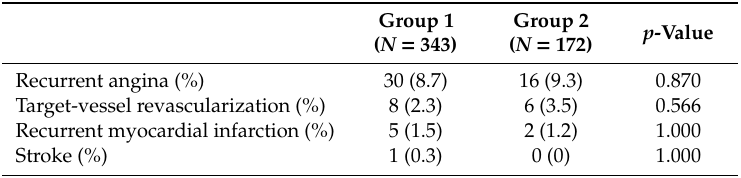
Table 3. One-year clinical outcomes of study